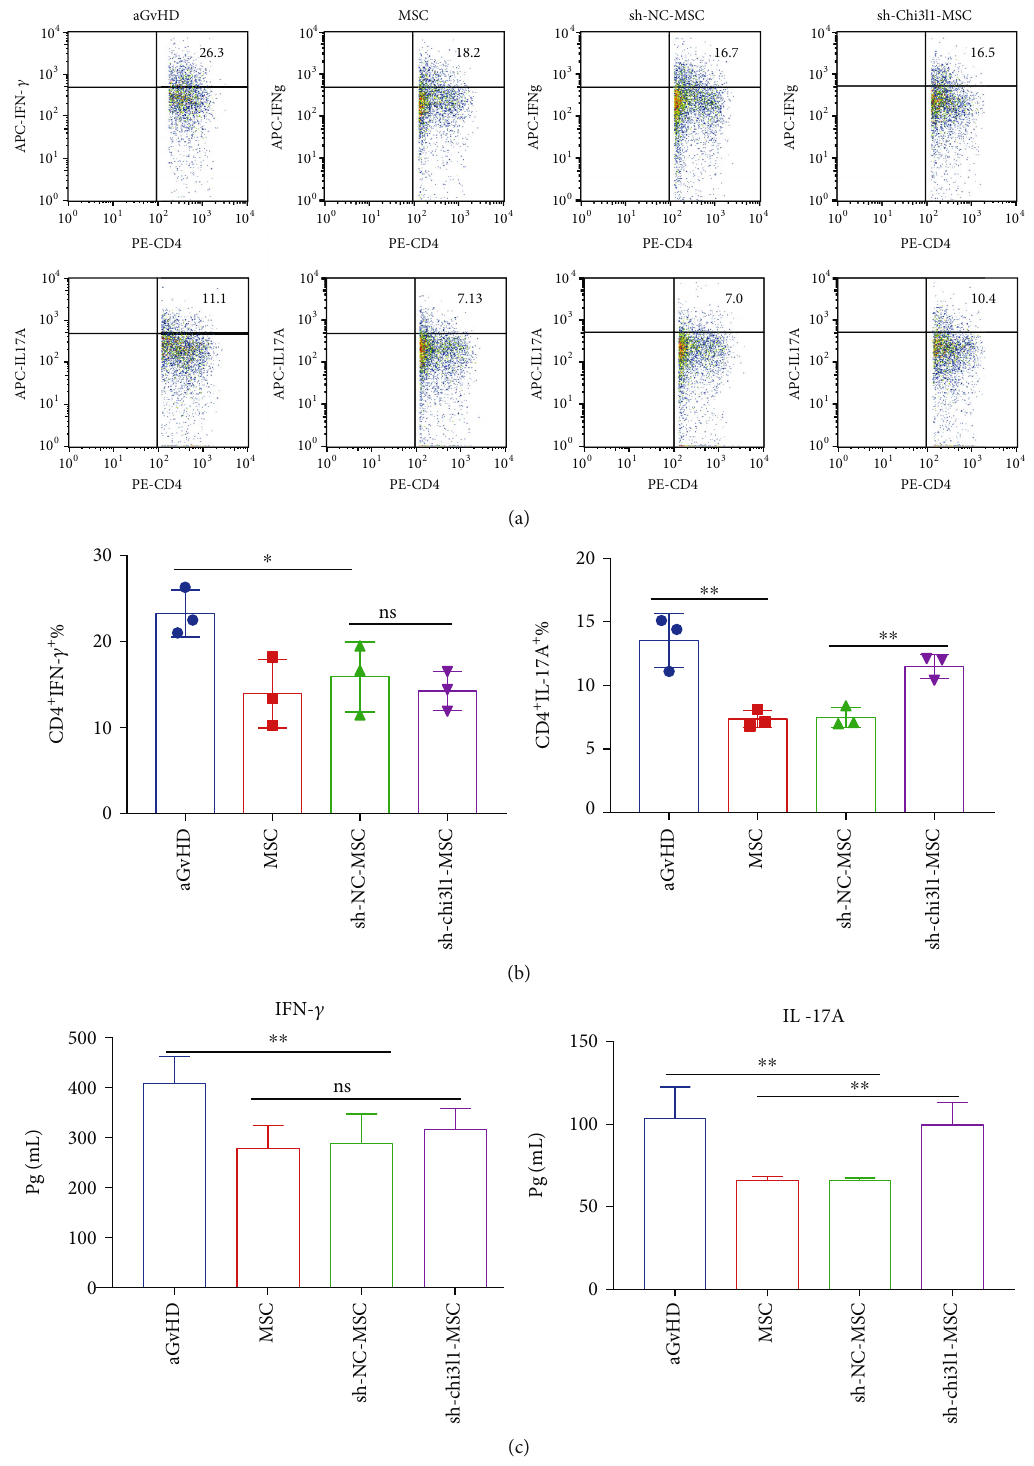
Figure 4: sh-Chi3l1-MSCs promote IL-17A production in aGvHD mice. (a, b) Lymphocytes were obtained from the spleens of aGvHD mice on day 14 after hUC-MSC, sh-Chi3l1-MSC, sh-NC-MSC ( 1 × 10 6 ), or PBS (0.2ml) treatment. Intracellular cytokines in lymphocytes were measured by fl ow cytometry. (a) IFN- γ and IL-17A were analyzed by fl ow cytometry. (b) The proportion of intracellular cytokines IFN- γ and IL-17A was measured in di ff erent groups. (c) Serum IFN- γ and IL-17A were measured by ELISA ( n = 8 , three independent experiments, one-way ANOVA, and Tukey ’ s multiple comparison test, ∗ P < 0 : 05 ; ∗∗ P < 0 : 01 ; ns: not signi fi cant). IFN- γ : interferon-gamma; IL-17A: